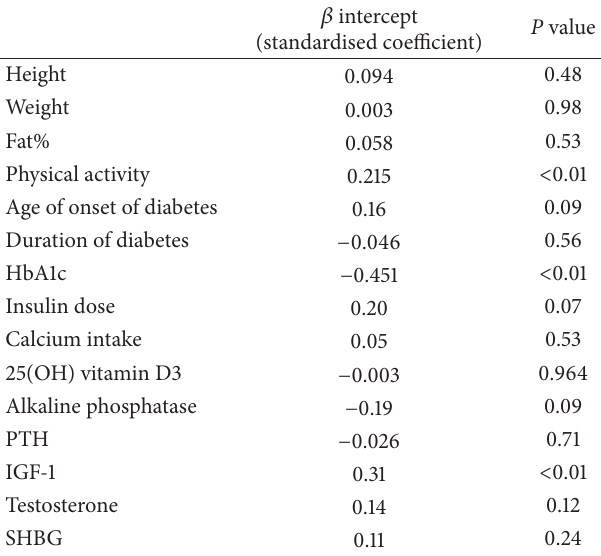
Table 8: Linear regression of parameters with BMD (lumbar spine) 𝑧 score ( 𝑅 2 = 0.669 ; 𝑃 < 0.01